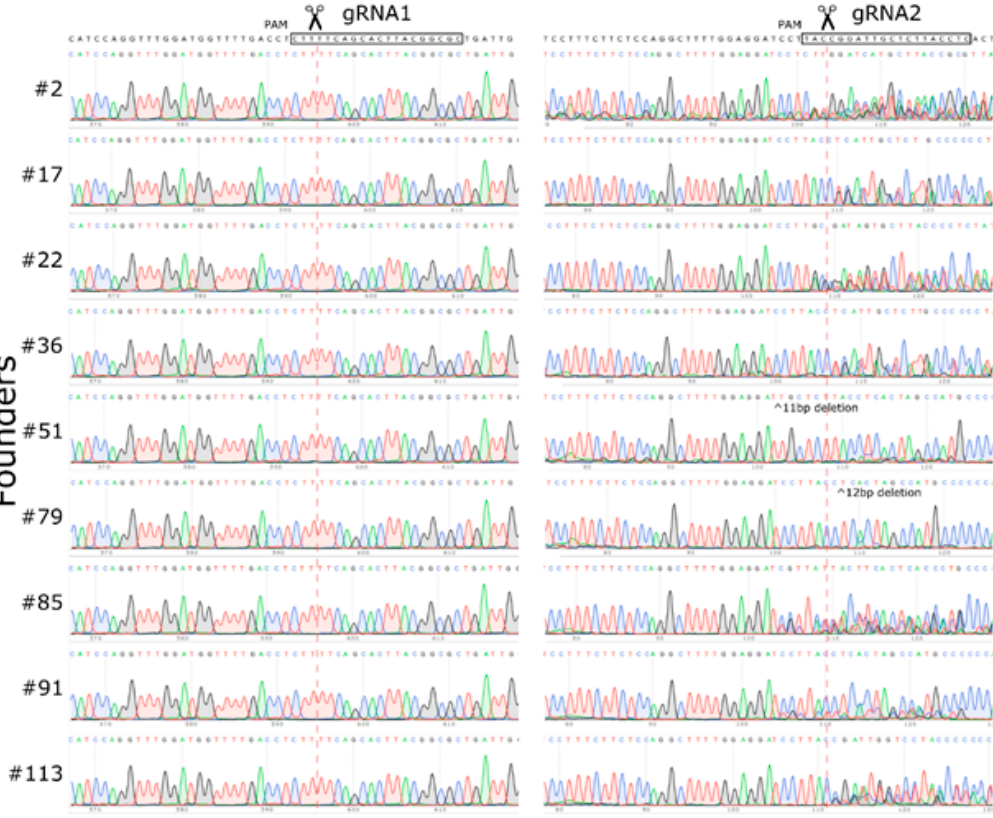
Figure 4. Sanger sequencing for gRNA1 and gRNA2 recognition sites in nine randomly selected founders. Overlapping peaks indicate the presence of heterozygous INDELs, resulting from the repair of DSB.